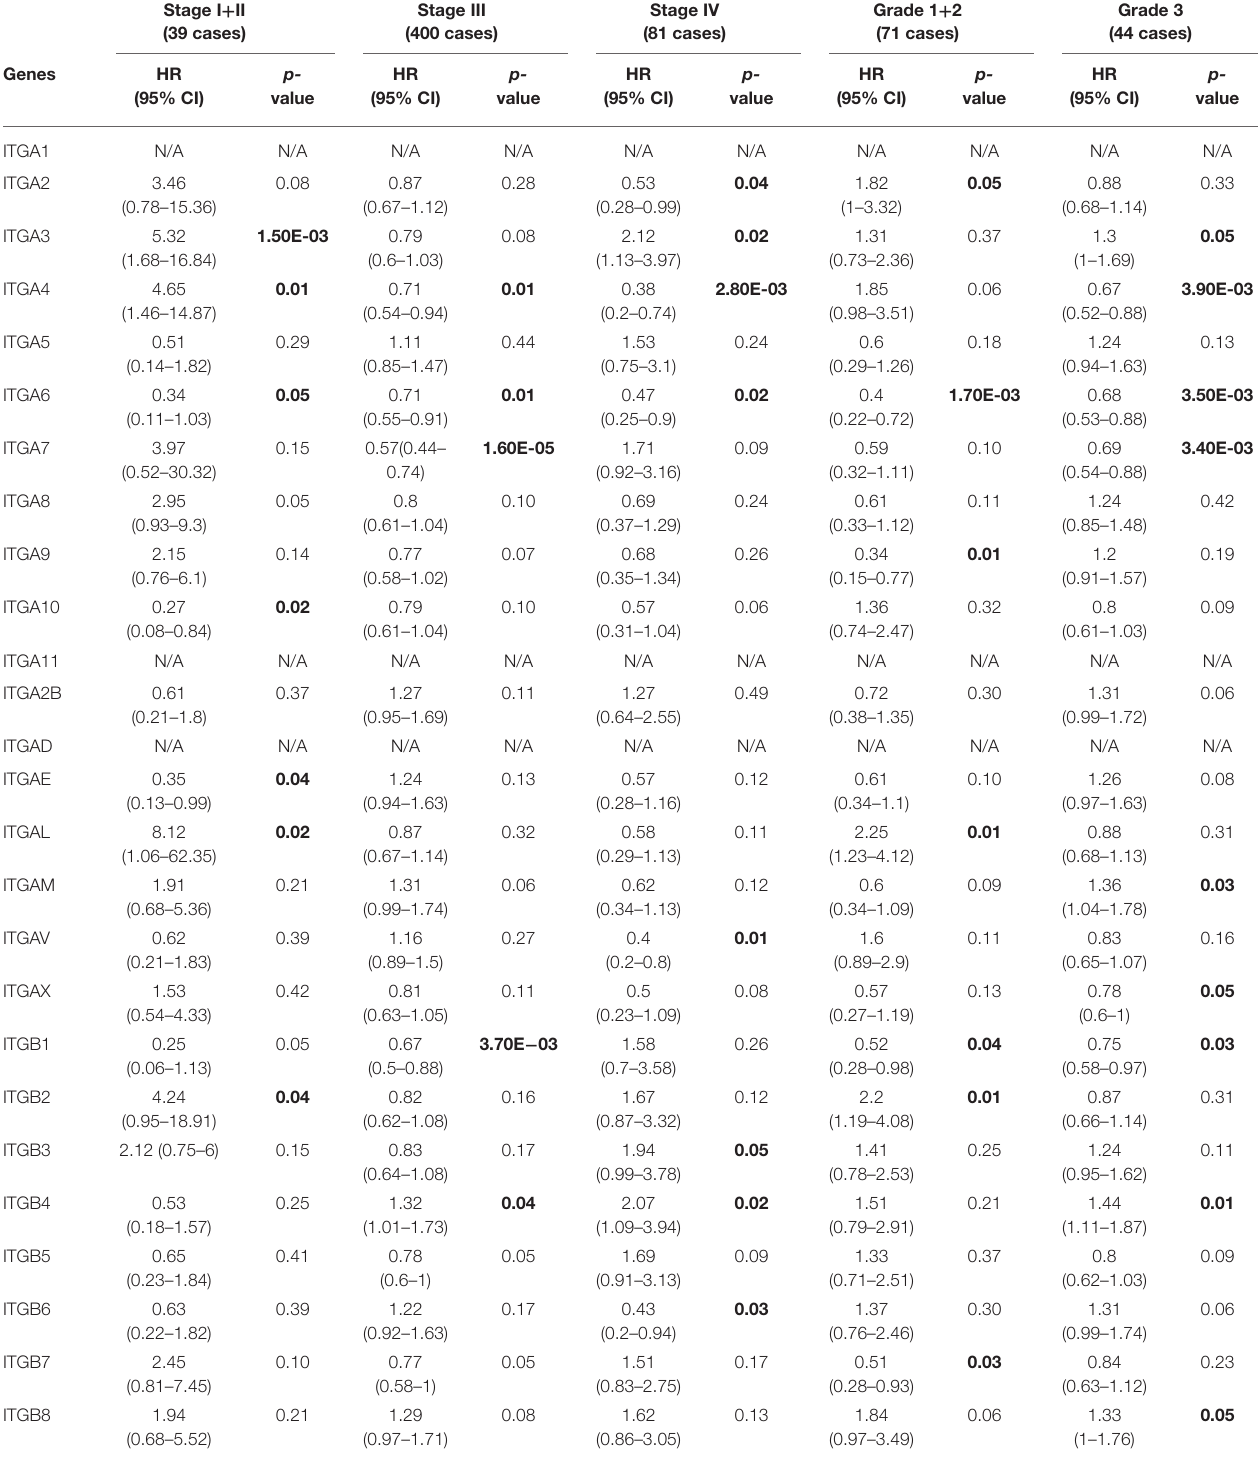
TABLE 3 | The relationship between integrins and PFS in different tumor grades and stages of OC (Kaplan–Meier plotter). Stage I + II (39